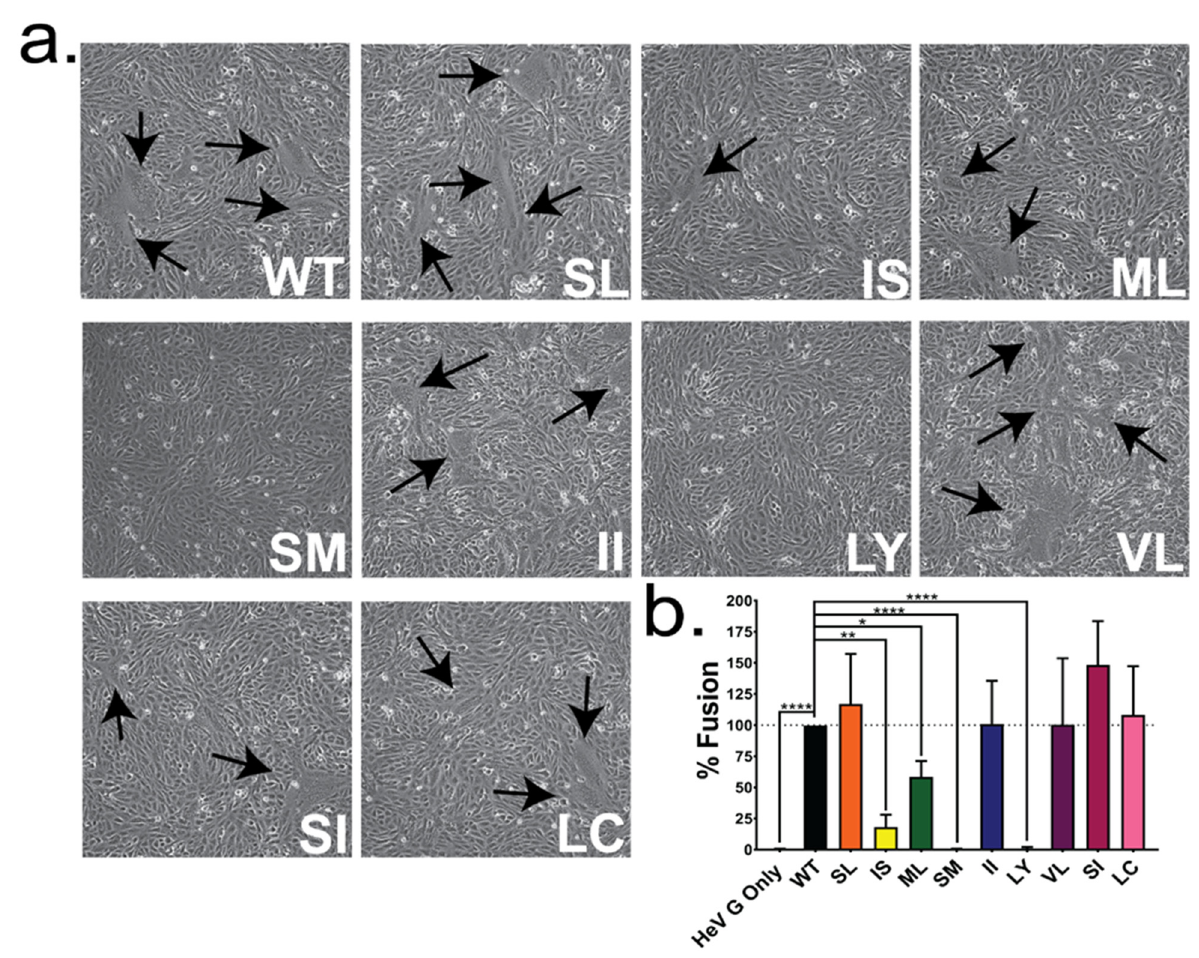
Figure 4. Mutations at residues IS, ML, SM, and LY in the HeV F TM reduce fusion. ( a ) Vero cells were transfected with the HeV attachment protein (G), and WT HeV F or one of the TM mutants. Syncytia formation was analyzed at 48 hpt. Black arrows indicate syncytia formation. Images are representative of 4 independent experiments. ( b ) A luciferase reporter gene assay was performed using BSR/T7 cells overlaid onto Vero cells transfected with HeV G and WT HeV F or each of the TM mutants at 24 hpt. Results are normalized to samples with WT HeV F and G and representative of 3 independent experiments, performed in duplicate. Significance was determined by one-way ANOVA. * = p < 0.05, ** = p < 0.01, **** = p < 0.001.